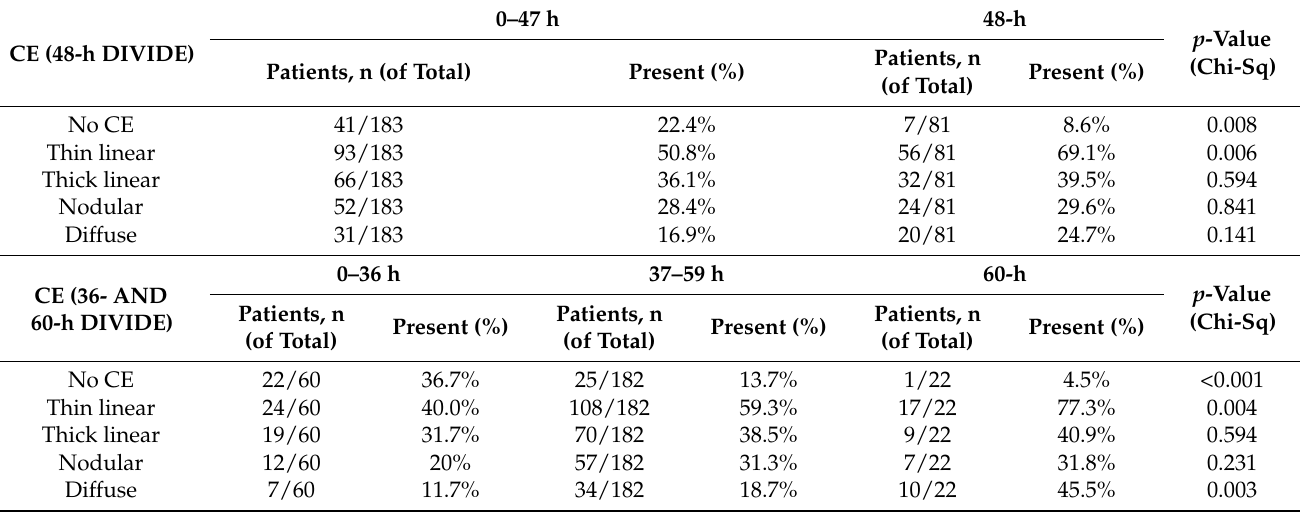
Table 1. Top: Distribution of different contrast enhancements before and after 48-h. Bottom: Distribu- tion of different contrast enhancements for three periods of time (0–36, 37–59, 60-h). More than one type of contrast enhancement can be present in one patient. Patients with measurable tumour were excluded from analysis.